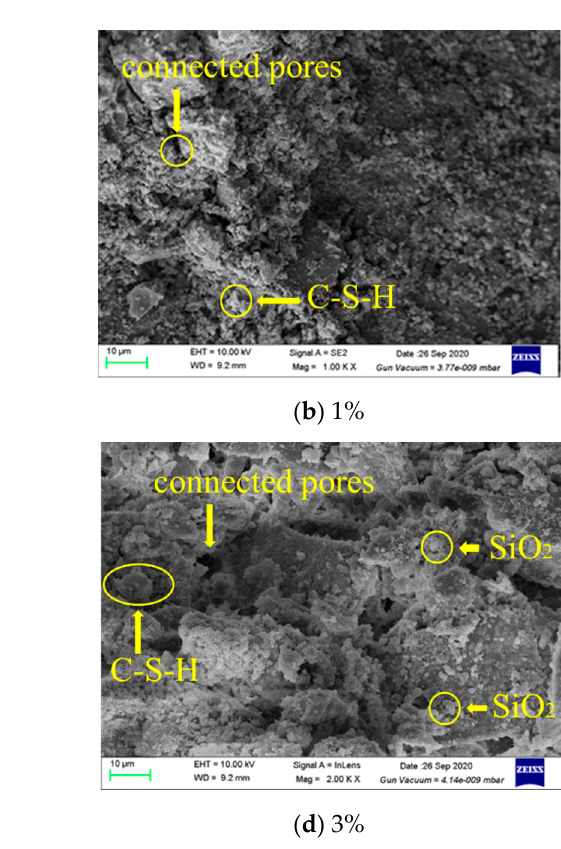
Figure 7. Schematic of interface transition zones [29].